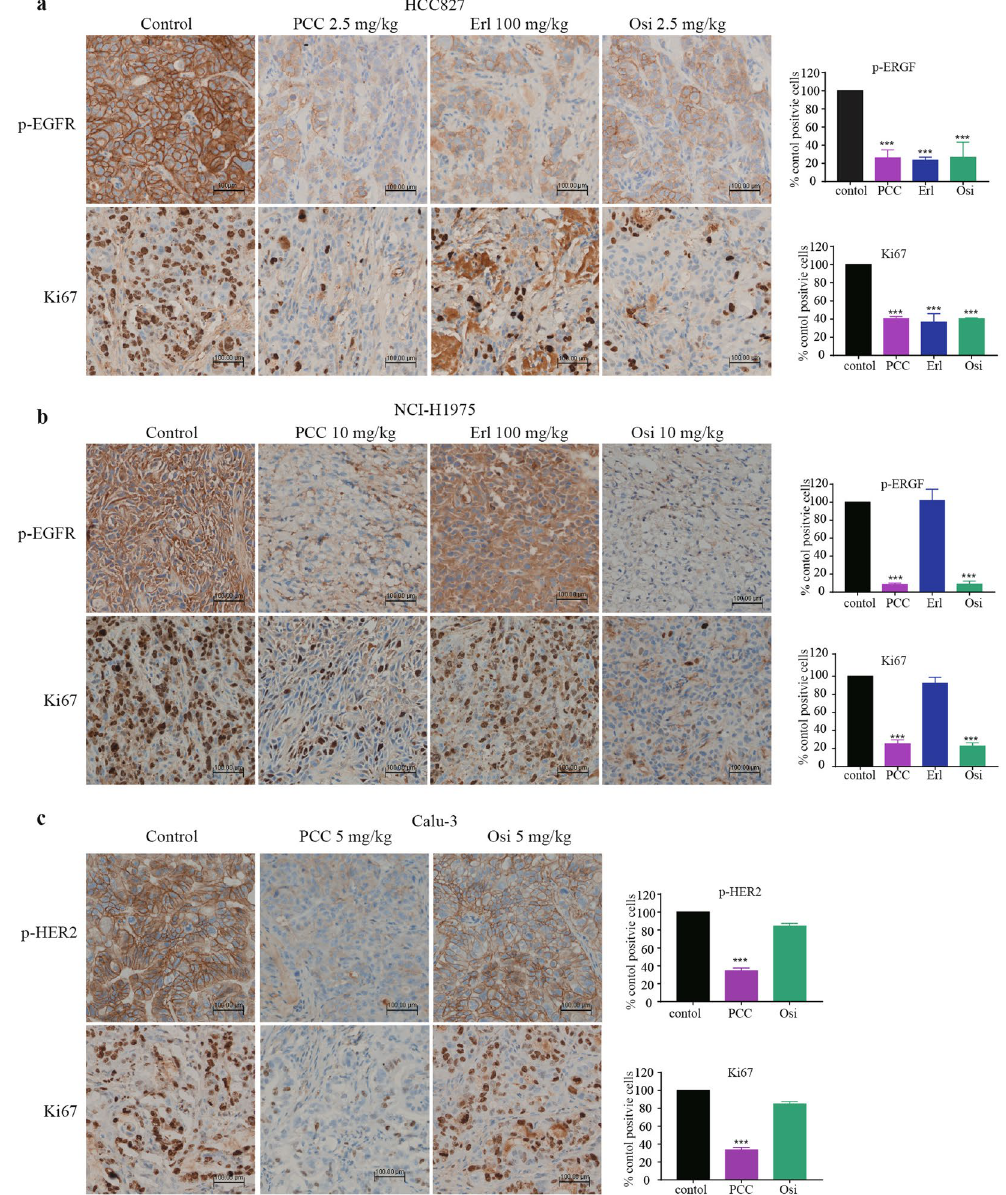
Figure 5. Mechanism of PCC0208027 anti-tumor activity in NSCLC tumor xenograft models. Ki67 and p-EGFR (or p-HER2) positive cells was observed in the tumor tissue (brown-colored objects) (200 × ). ( a ) PCC0208027, erlotinib, and osimertinib strongly decreased the number of p-EGFR and Ki67 positive cells in tumor tissues in comparison to the control group in HCC827 xenograft model. ( b ) PCC0208027 and osimertinib strongly decreased the number of p-EGFR and Ki67 positive cells in tumor tissues in NCI-H1975 xenograft model. ( c ) PCC0208027 significantly reduce the number of p-HER2 and Ki67 positive cells in tumor tissues in comparison to the control group in Calu-3 xenograft model. Columns, mean; bars, *** P < 0.001, compared to the control